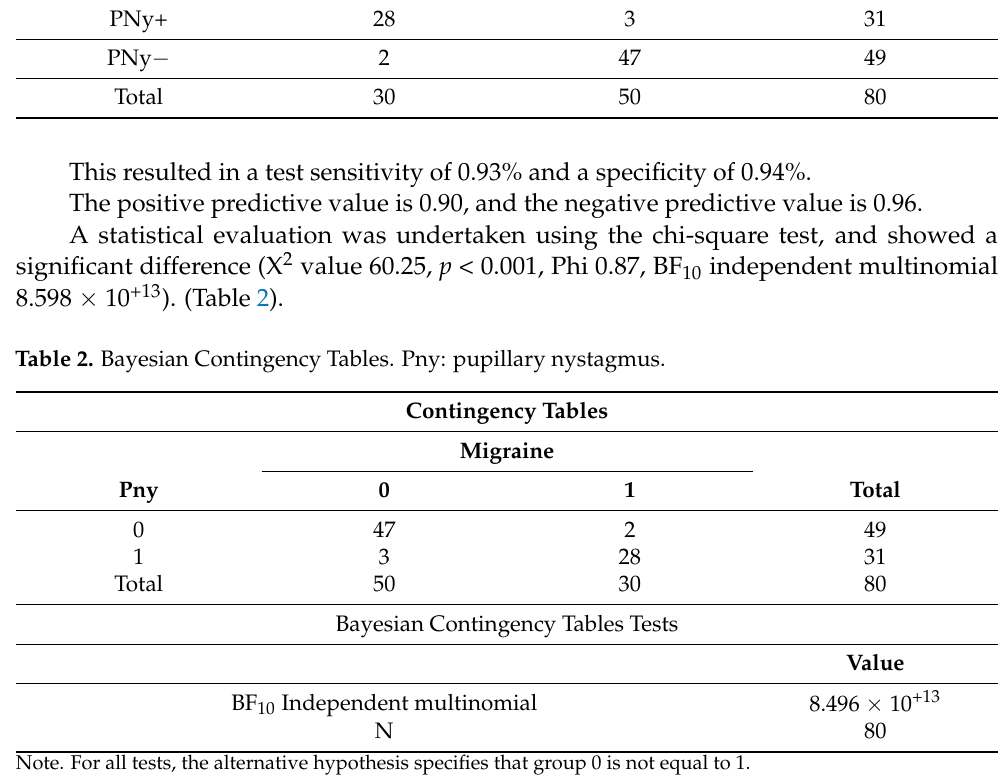
Table 1. Prevalence of pupillary nystagmus in patients with vestibular migraine and in non-migraine patients. VM: vestibular migraine; No VM: dizzy patients not suffering from vestibular migraine; PNy+ patients presenting with pupillary nystagmus; PNy − patients who do not have pupillary nystagmus. VM